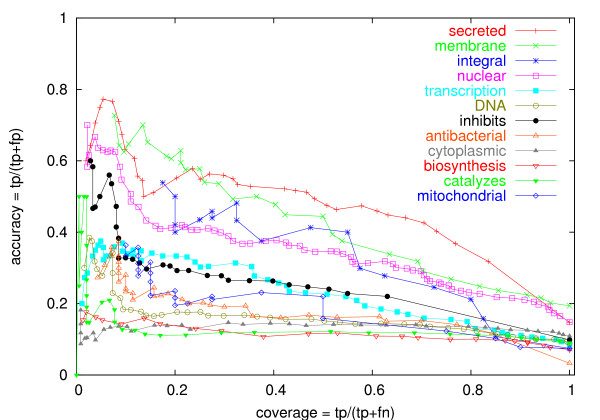
Performance of fixed-target function predictors. Twelve function predictors were evolved with fixed targets (listed in the Methods) instead of the evolved targets used in the self-supervised approach. Each predictor is constructed from 100 independently evolved classifiers, and its "prediction score" is simply the fraction of positive classifications (out of 100). Accuracy and coverage are presented at all possible prediction score thresholds (stopping when the number of positive predictions falls below 10). In the accuracy and coverage calculations: tp = true positives, tn = true negatives, fp = false positives, fn = false negatives.